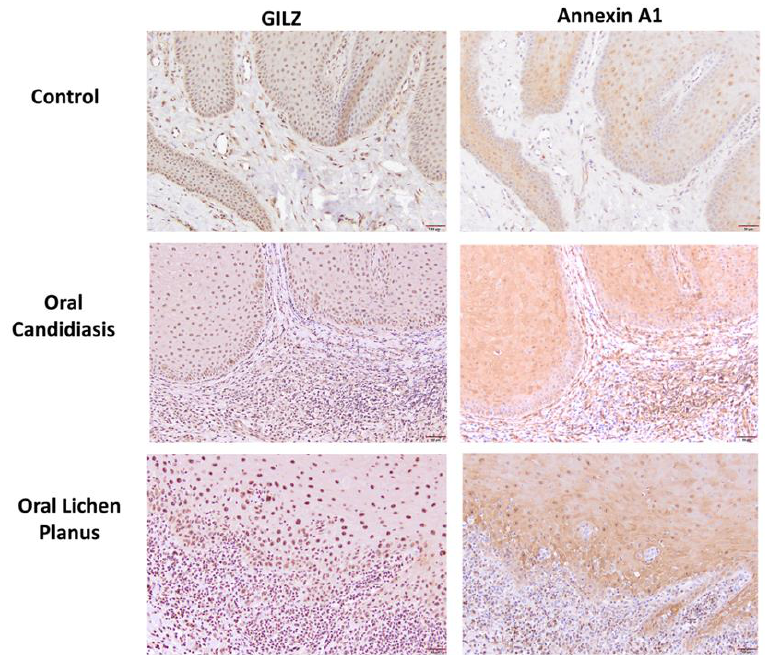
Figure 4. Panels show immunohistochemical staining for Annexin A1 in three tissue specimens from each group of control, oral candidiasis, and oral lichen planus. Each condition displayed nuclear, cytoplasmic and cell membrane staining for Annexin A1, albeit to varying extent as described under Results. Scale bar: 100 μm.